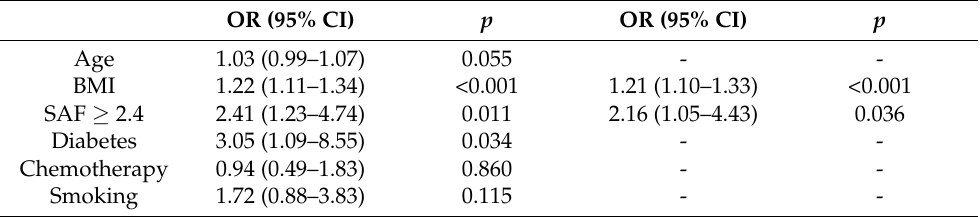
Table 4. Logistic regression model for macrovesicular steatosis ≥ 10%.